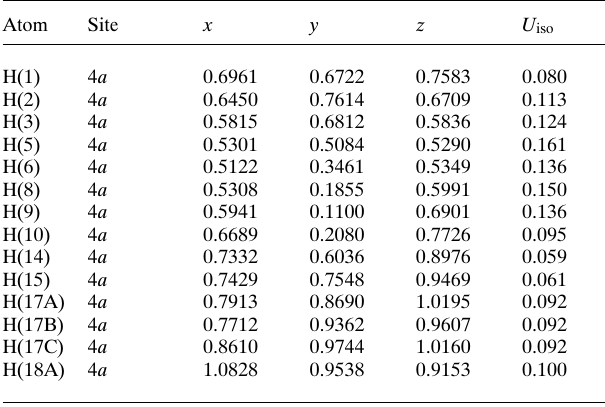
Table 2. Atomic coordinates and displacement parameters (in Å 2 )